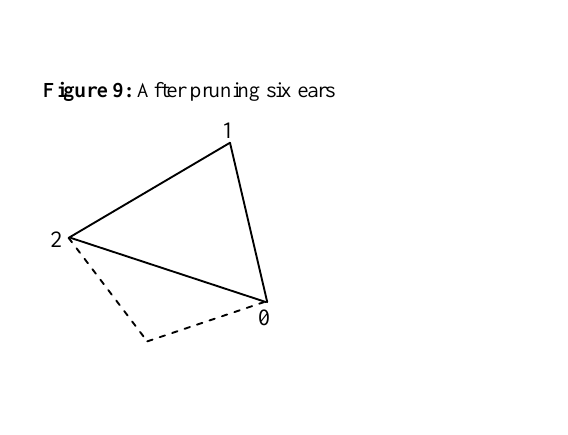
Figure 9: After pruning six ears